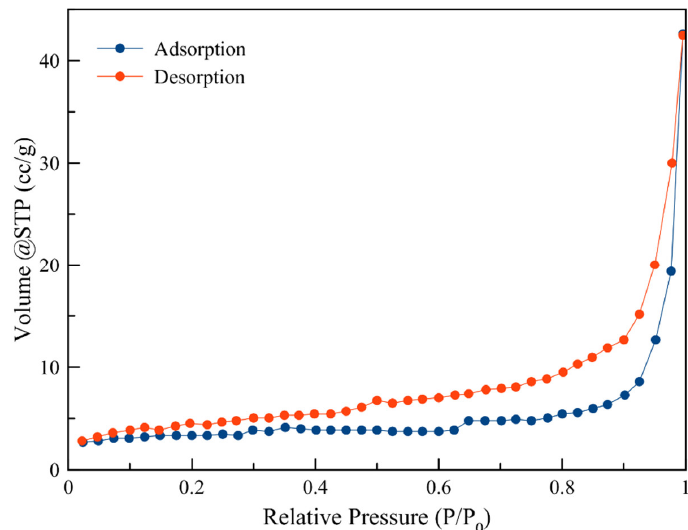
Figure 2. Adsorption-desorption isotherms of NZU.